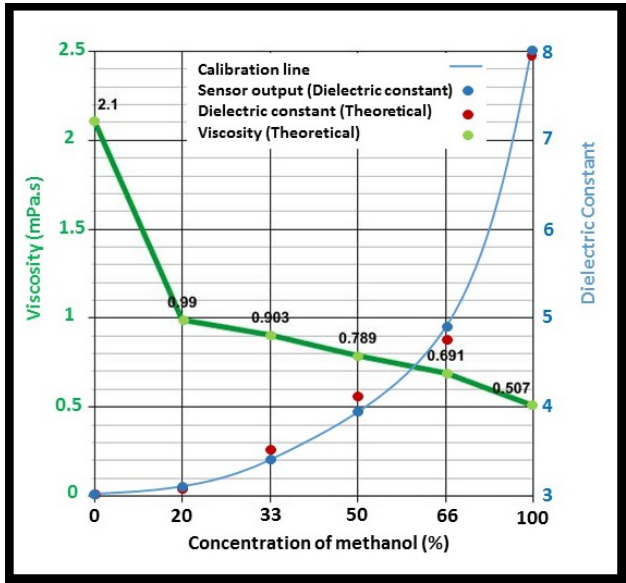
Figure 7. Viscosity and permittivity variation of the isopropanol-methanol mixture with respect to methanol